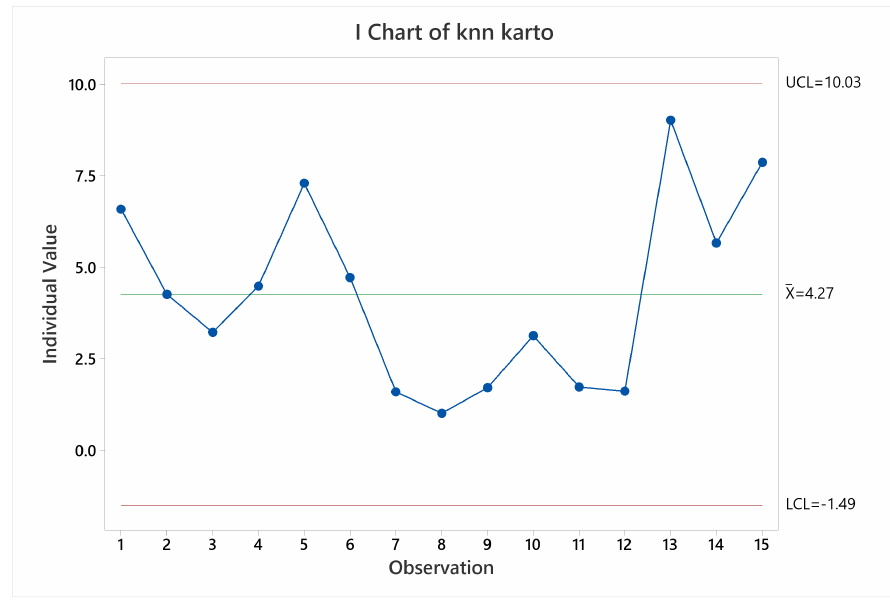
Figure 26. Map accuracy mean behavior for